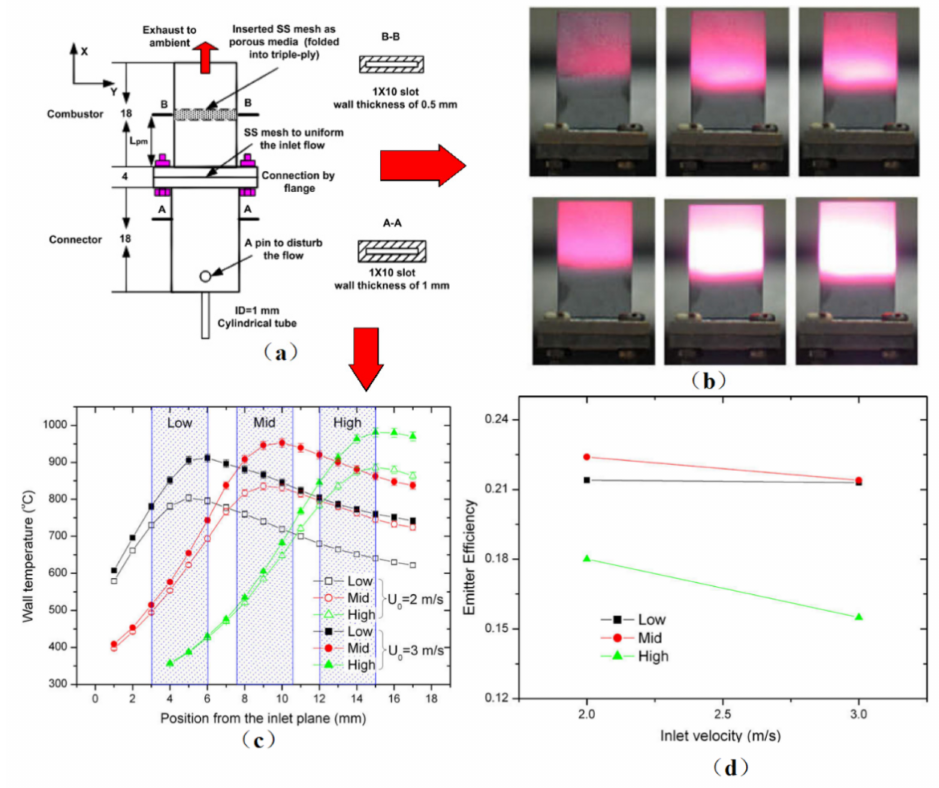
Figure 31. Influences of position of the porous media on combustion characteristics. ( a ) Combustion structure, ( b ) Experimental result, ( c ) Wall temperature, ( d ) Emitter